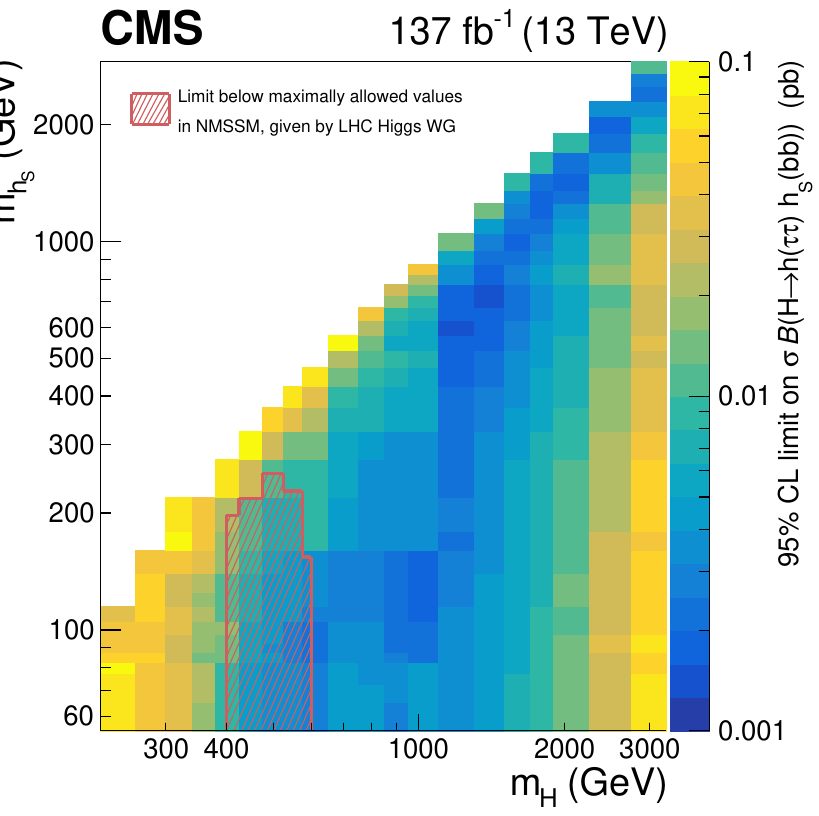
(bb)) for all tested pairs of m S